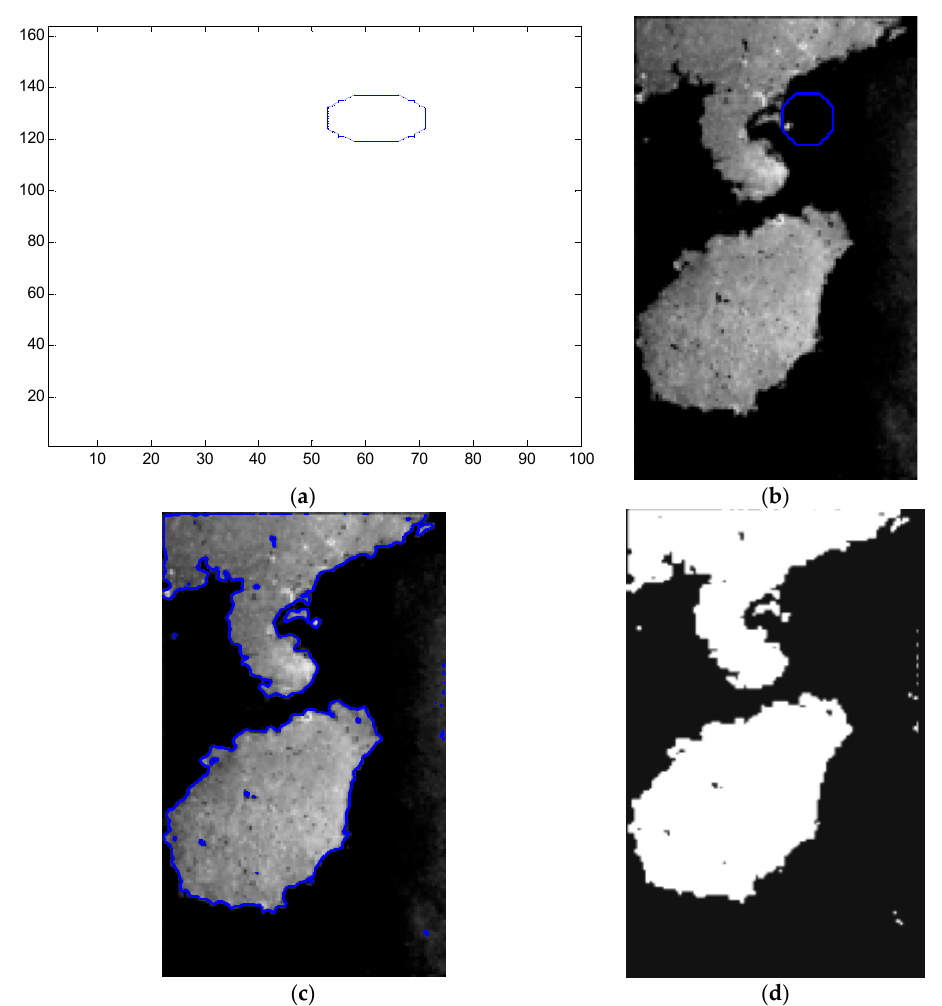
Figure 8. Small initial contour extraction results: ( a ) Small initial contour of target image; ( b ) The position of initial contour in target image; ( c ) Shoreline extraction result; ( d ) Binary map of the extraction results of shoreline.